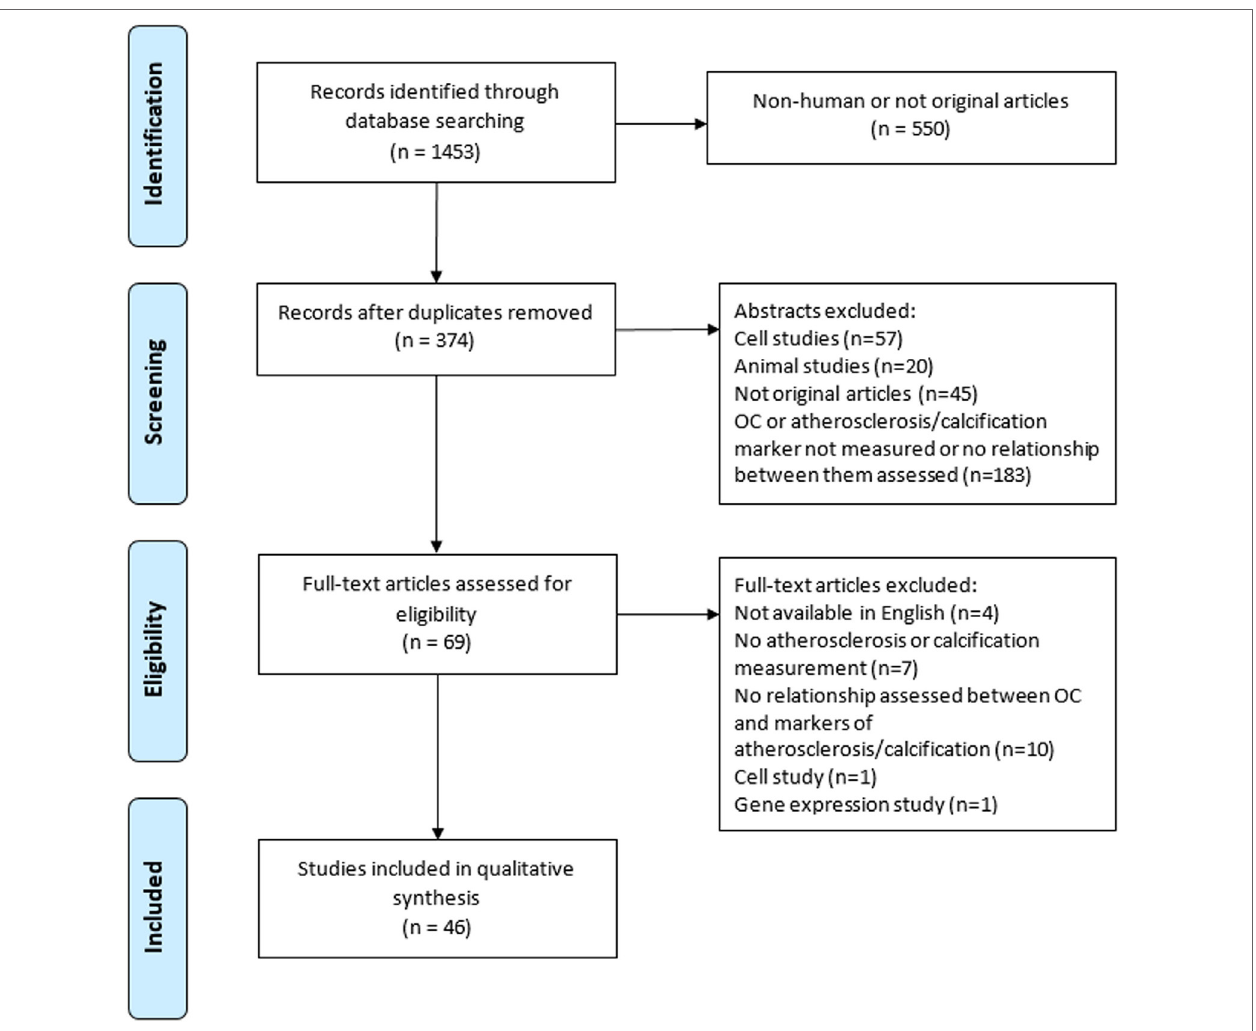
FigURe 1 | Flow chart for study retrieval and selection. Abbreviation: OC,